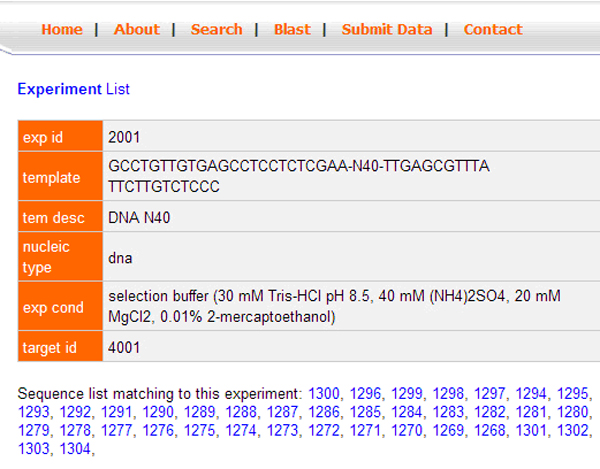
View of experiment details.